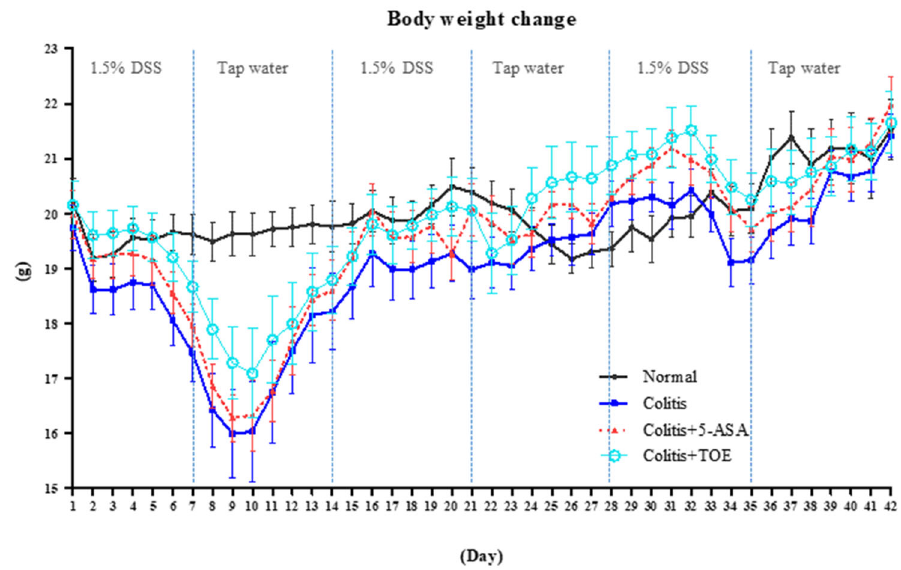
Figure 4. Effect of M2 fraction of Turbinaria ornata extract (TOE) on body weight in C57BL/6 mice with dextran sulfate sodium (DSS)-induced chronic colitis. The body weight of each mouse was measured daily. The values are presented as the mean body weight of each group ± SD. Normal, DSS- / D.W; colitis, DSS + / D.W, colitis + 5-aminosalicylic acid (5-ASA), DSS + / 5-ASA 50 mg per kg; colitis + TOE, DSS + / TOE 15 mg per kg.